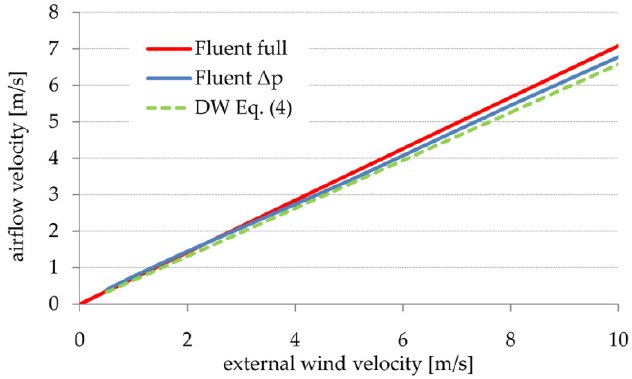
Figure 10. Airflow velocity induced by the external wind calculated in different ways.